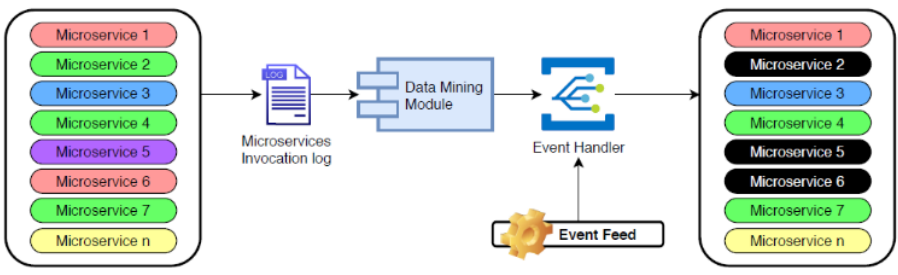
Figure 11. Mutation actions schema.